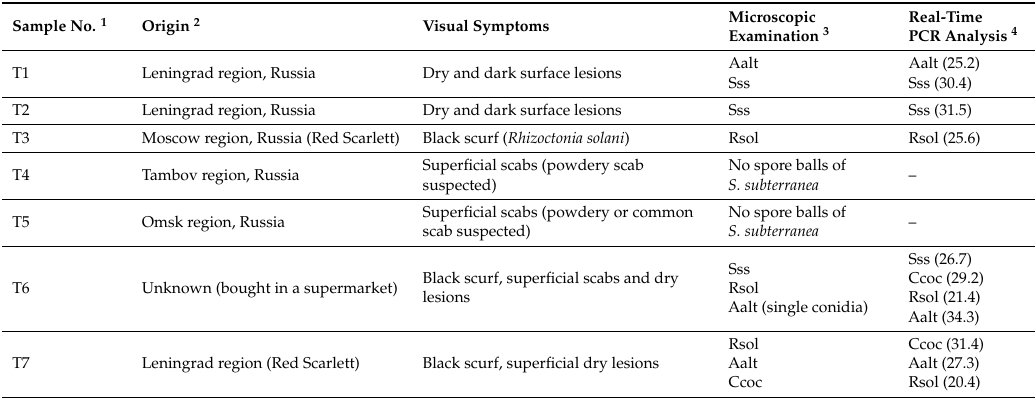
Table 8. Validation of a diagnostic efficiency of a qPCR microarray for detection of fungal pathogens of potato using field samples of potato leaves and